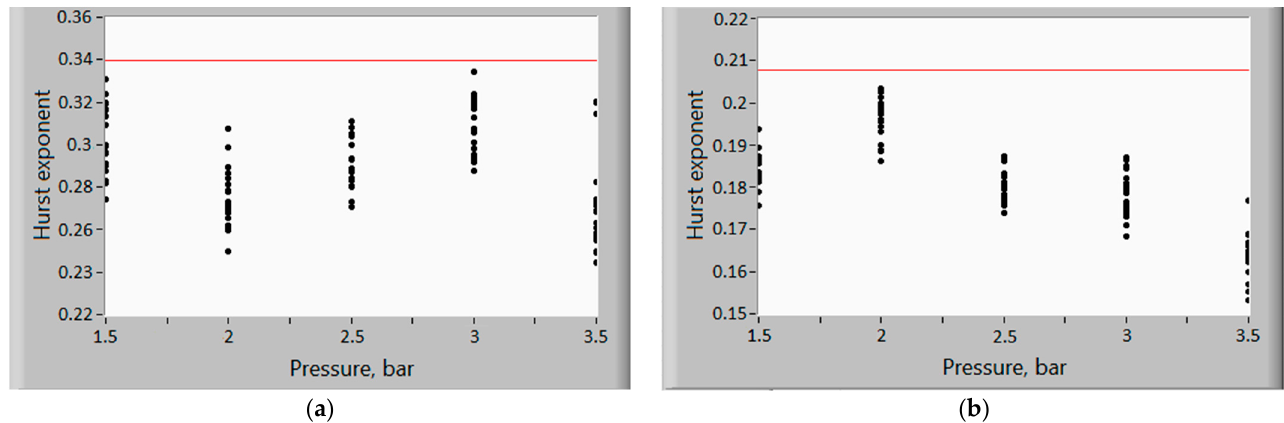
Figure 5. Formation of the confidence interval: ( a ) for X-axis signals, ( b ) for Y-axis signals. The border of the confidence interval is shown with a red line. For signals recorded along different axes, their own confidence interval was formed (Figure 5a—along the X axis, Figure 5b—along the Y axis), due to the fact that the values of the Hurst exponent for different axes differ significantly. As can be seen from the graphs, the Hurst exponent at different pressures in the absence of a leak in the pipe is approximately at the same level. Acoustic signals are antipersistent, which indicates the presence of a turbulent flow. This assumption is confirmed by calculations of the Reynolds number (Table 3)